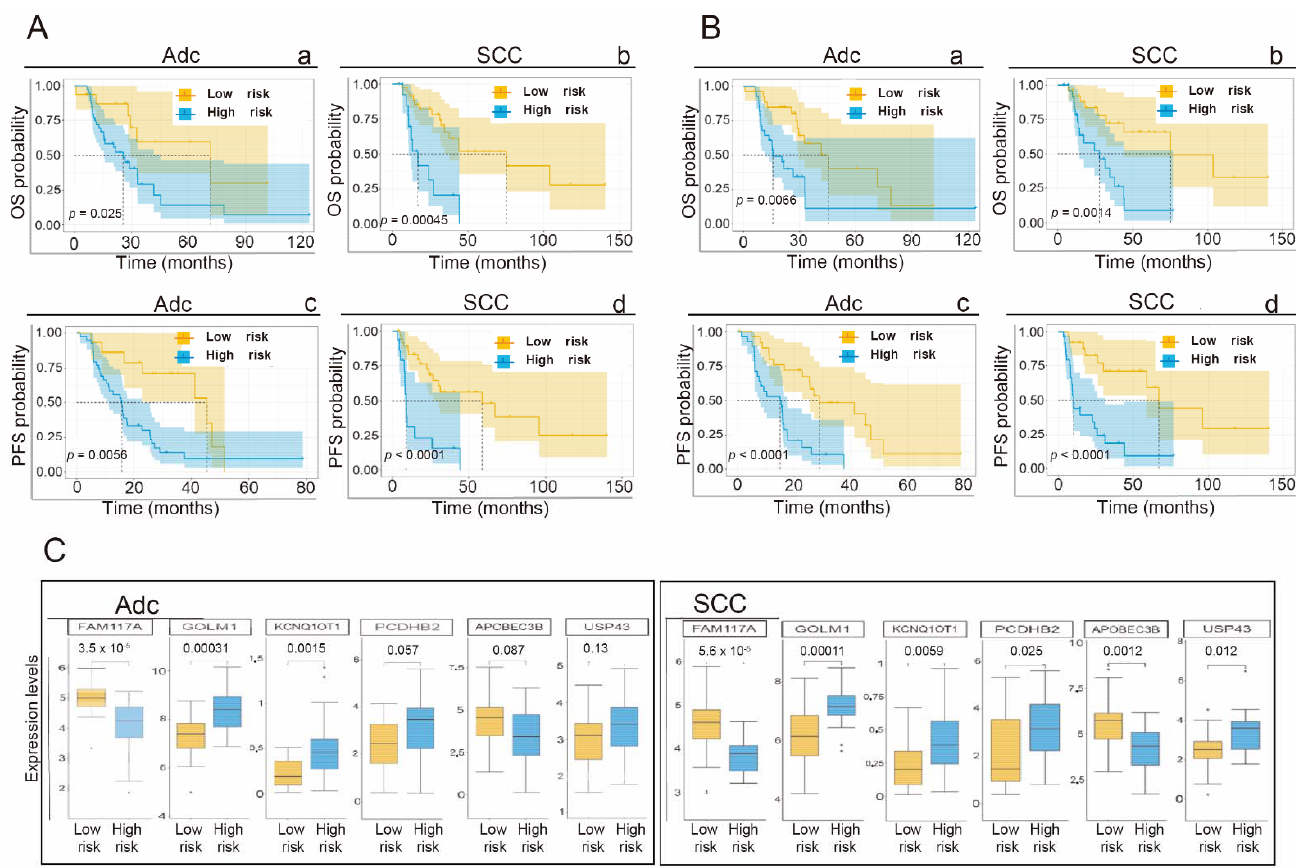
Figure 6. ( A ) Kaplan–Meier curves in which the probabilities of OS and PFS are represented as a function of the risk group associated with the gene signature for the subgroup of patients with adenocarcinoma, Adc, (a and b) and for the squamous, SCC, subtype (c and d). Each graph shows the number of patients at risk for different times. The value obtained from the analysis of the global cohort was used as a cutoff point to separate both groups, SCC and Adc. ( B ) Kaplan–Meier curves in which the probabilities of OS and PFS are represented as a function of the risk group associated with the gene signature for the subgroup of patients with adenocarcinoma, Adc, (a and b) and for the squamous, SCC, subtype (c and d). Each graph shows the number of patients at risk for different times. The median of the risk score values of each cohort, Adc or SCC, was independently used as a cutoff point to separate each respective group. ( C ) Box diagram showing the expression levels (logTPM) on the ordinate axis of each gene that makes up the gene signature according to the prognostic group (low or high risk). The results of the adenocarcinoma cohort analysis (a) and squamous cell carcinoma analysis (b) and the gene elements are ordered from left to right according to the p ‐value (Mann–Whitney U test). *, p < 0.05; **, p < 0.01.